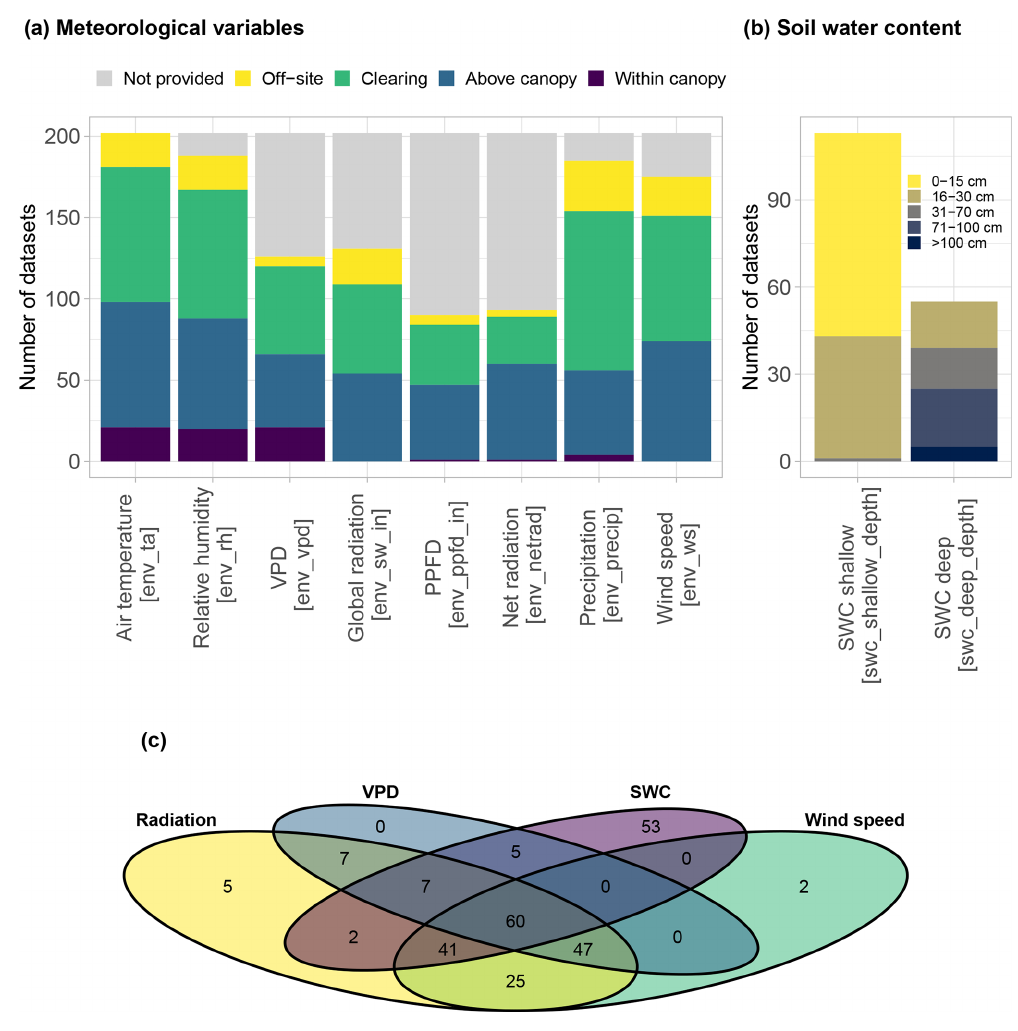
Figure 8. Summary of the availability of different environmental variables in SAPFLUXNET datasets. (a) Distribution of meteorological variables according to sensor location (in brackets, names of the variables in the database). (b) Distribution of soil moisture variables according to the measurement depth (in brackets, names of the variables in the database). (c) Venn diagram showing the number of datasets where each combination of different environmental variables are present, grouping shortwave, photosynthetic photon flux density (PPFD), and net radiation under “radiation”